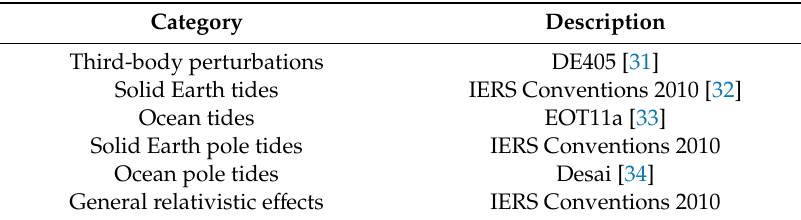
Table 2. Background force models.